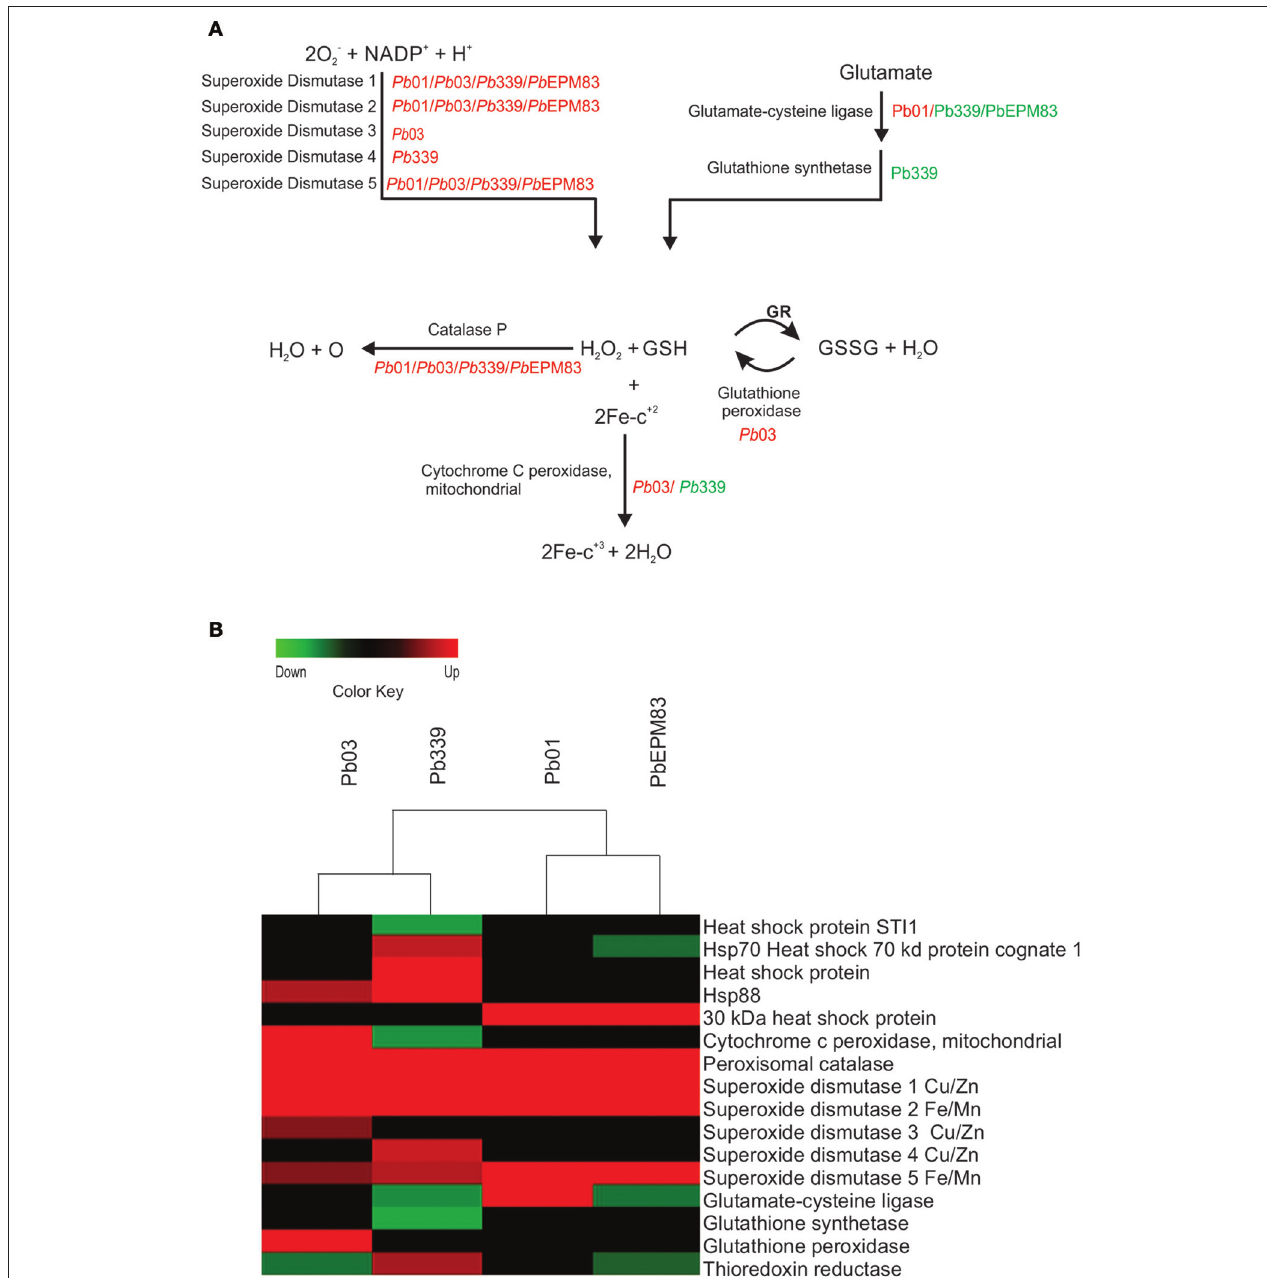
FIGURE 8 | Comparison of protein profiles related to detoxification mechanisms against oxidative stress in P. lutzii and isolates of P. brasiliensis . Dataset comparisons were carried out as cited in Figure 2 legend. (A) Changes in expression levels in yeast cells incubated with acetate in Pb01, Pb 03, Pb 339, and Pb EPM83 are represented in a heat map format. (B) Representative diagram of the detoxification mechanisms against oxidative stress pathways depicting down-regulated (green) and up-regulated (red) proteins in the isolates as cited above. Black indicates that no significant difference was observed. Glutathione (GSH) ; glutathione reductase (GR); glutathione disulfide